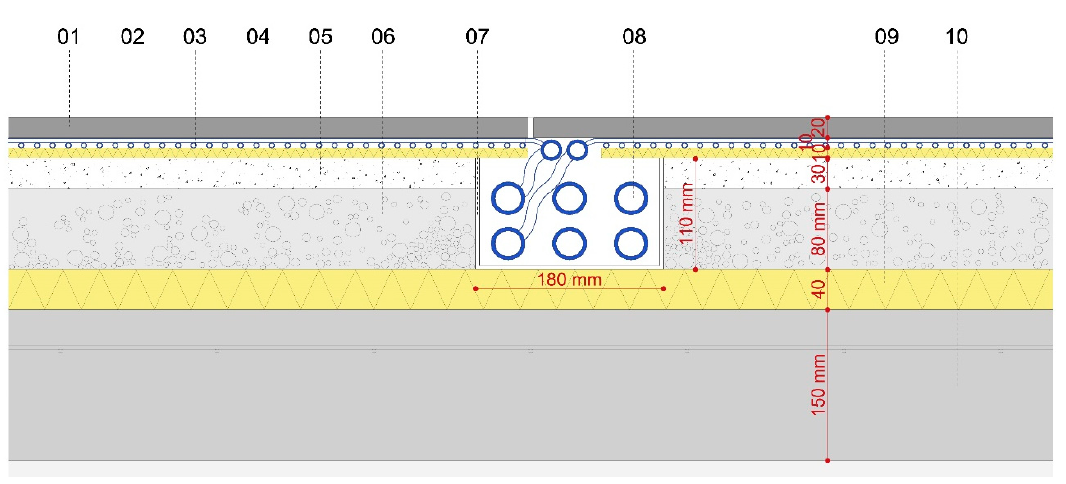
Figure 6. Ceramic thermal conditioning panel applied to the MUA floor. 01: Large-format porcelain stoneware piece. 300 × 100 × 2 cm. 02: Adhesive layer. Beka Thermal Conductive Paste V. WLP. 1. Thickness: 6 mm. 03: PPR capillary mat. Diameter: 3 mm. Separation: 10 mm. 04: Polyurethane foam thermal insulator. Thickness: 10 mm. 05: Regulatory layer. Self-levelling cement mortar. Average thickness: 10 mm. 06: Coating of screed: expanded clay. Thickness: 80 mm. 07: Aluminium channels to pass the PPR distribution pipes through. 08: PPR distribution pipes. Diameter: 32 mm. 09: Thermal insulator. Type IV expanded polystyrene. Thickness: 40 mm. 10: Reinforced concrete slab with electrowelded mesh 150 × 150 mm. Thickness: 150 mm.